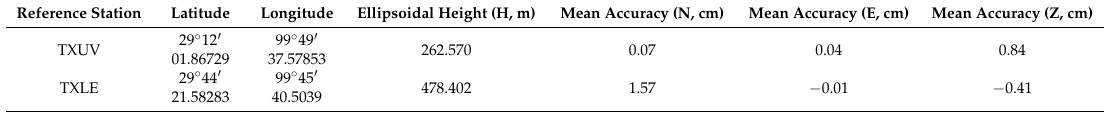
Table 1. CORS stations TXUV and TXLE, and positional accuracies as reported in